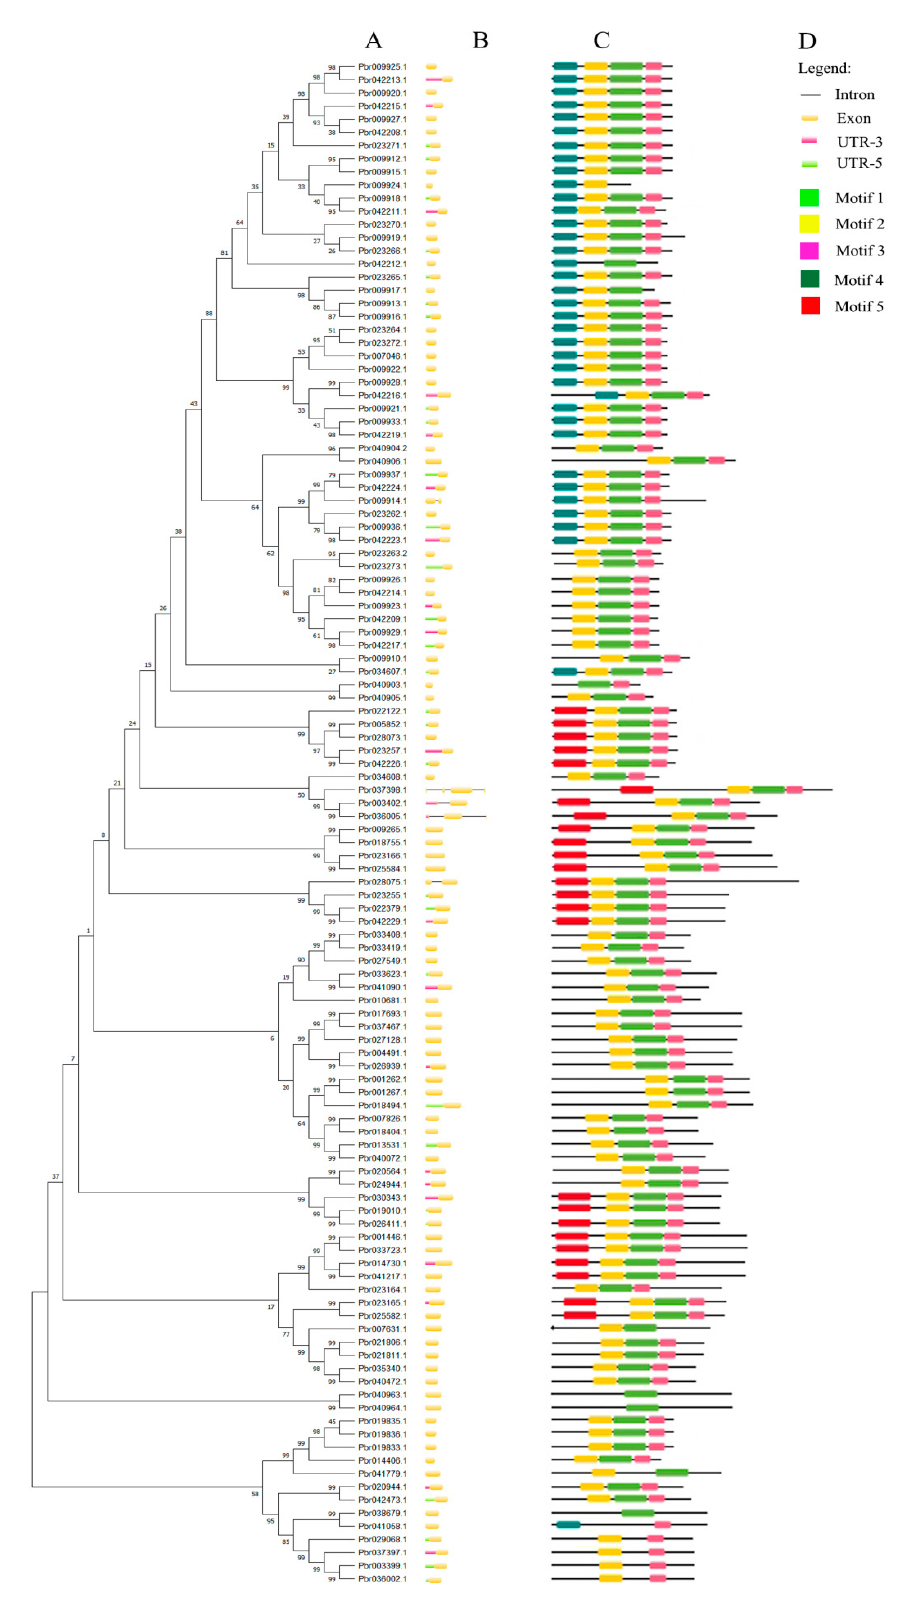
Figure 2. Predicted the conserved motif and exon-intron structure of ‘Dangshansu pear’ SAUR gene. ( A ) Phylogenetic tree of PbrSAUR family members; ( B ) exon-intron structure of PbrSAUR family members, black lines indicate introns and yellow wedges indicate exons; ( C ) conserved elements of PbrSAUR family members; ( D ) the color and a corresponding number of each motif box.